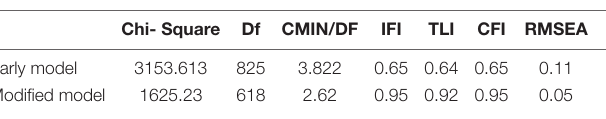
TABLE 2 | Model fit summary.